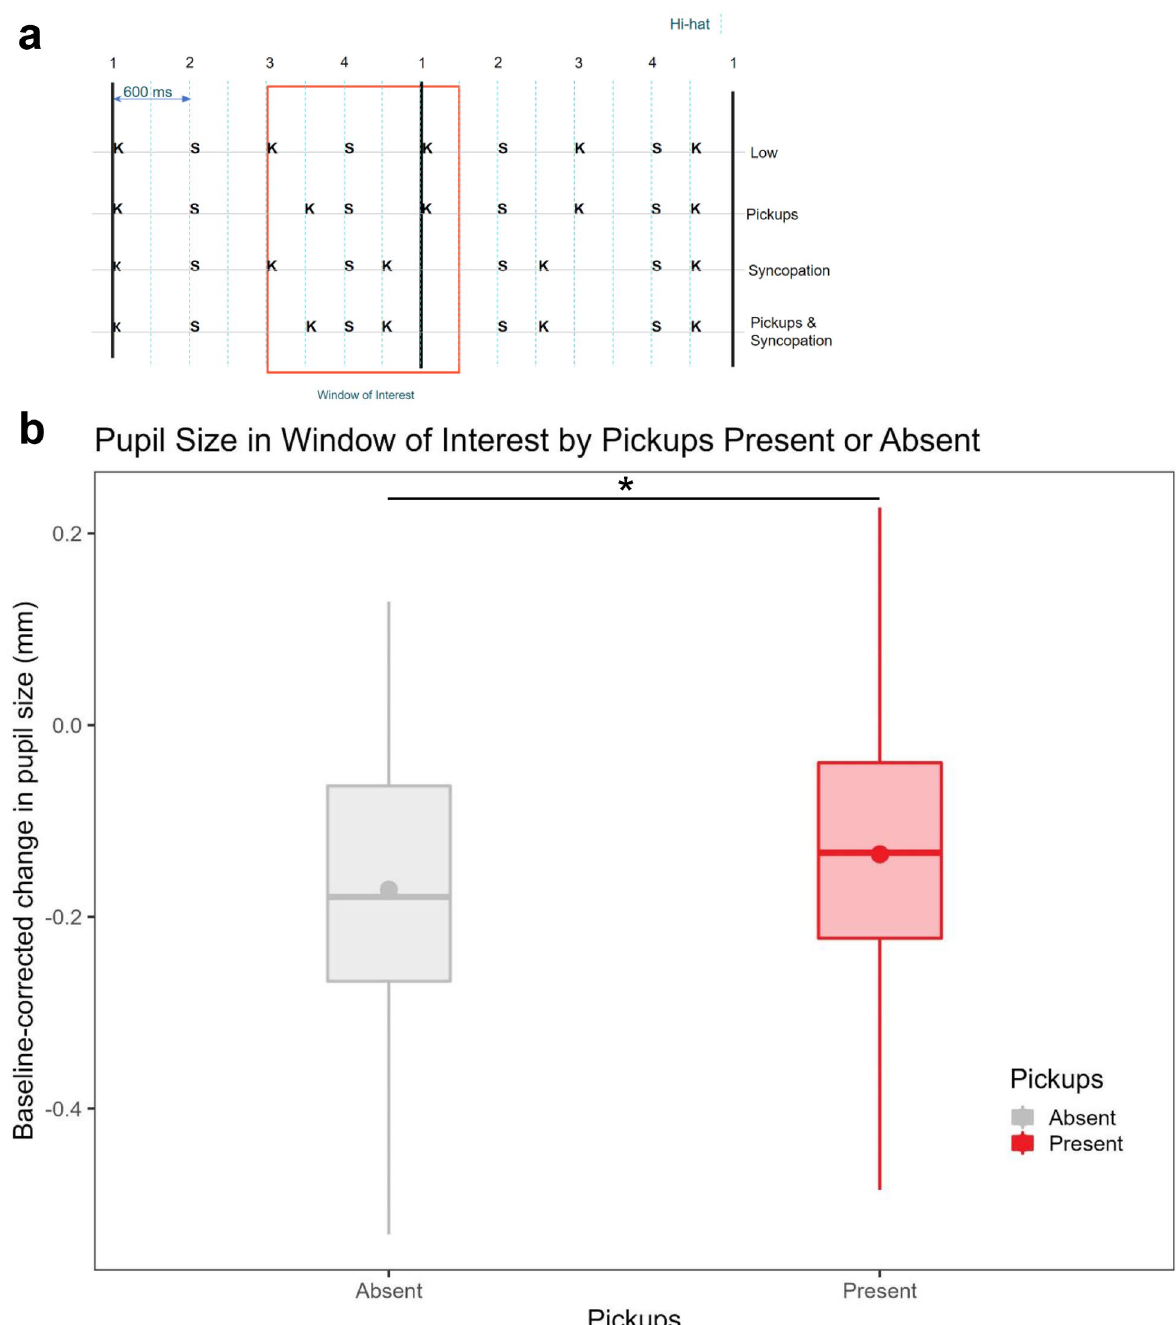
Figure 7. Pupil Size analysis by pickups (Present or Absent) and syncopations (Present or Absent) in the window of interest where the pickup manipulation occurred. ( A ) Window of interest for further analysis. Dashed lines represent hihat hits while Ks represent kick drum hits and Ss represent snare drum hits. Low = Pickups absent, Syncopations Absent, Pickups = Pickups Present, Syncopations Absent, Syncopation = Pickups Absent, Syncopations Present, Pickups and Syncopation = Pickups Present, Syncopations Present. ( B ) Boxplots showing pupil size in the window of interest by Pickups and Syncopation. Large dots and triangles represent group